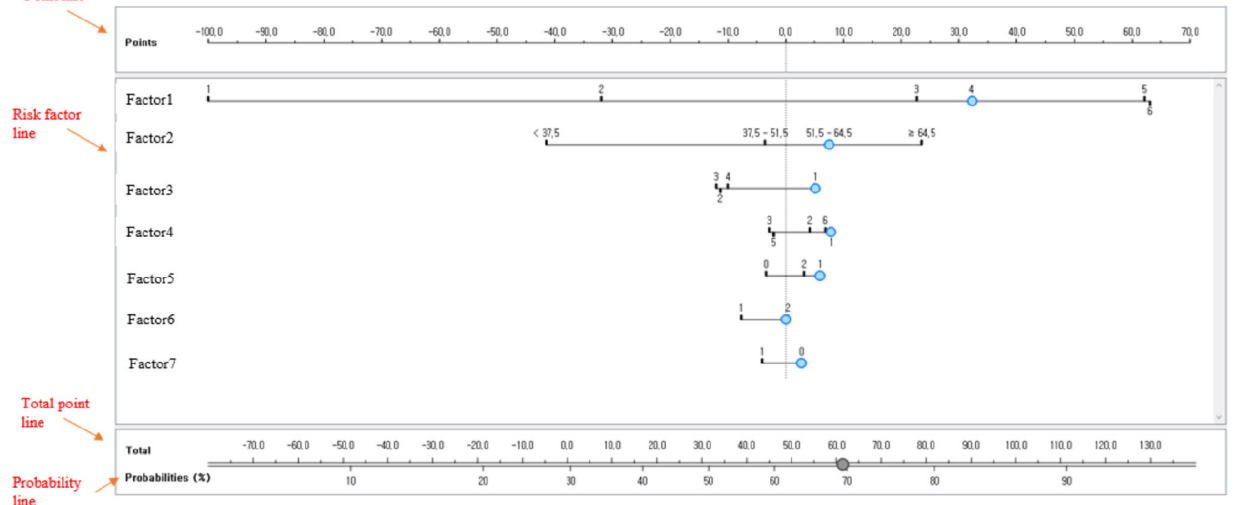
Figure 1. Example of a Bayesian nomogram [11].